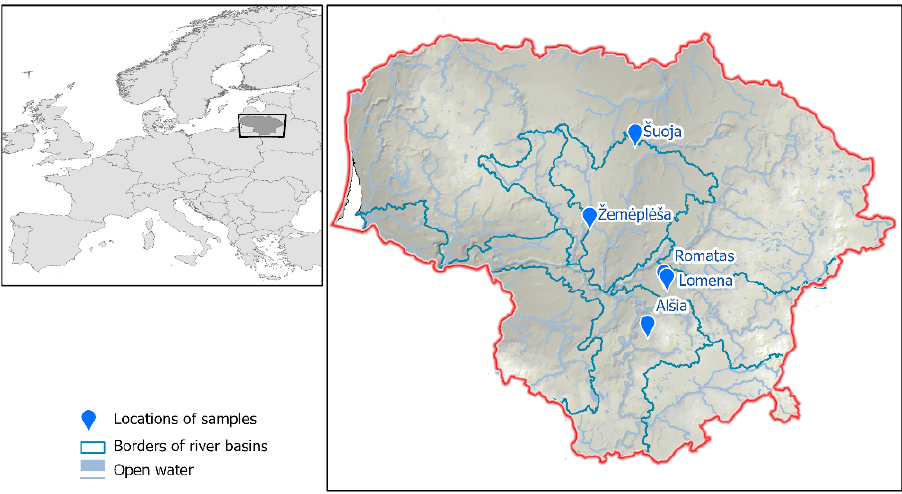
Figure 1. Location of study area and samples.